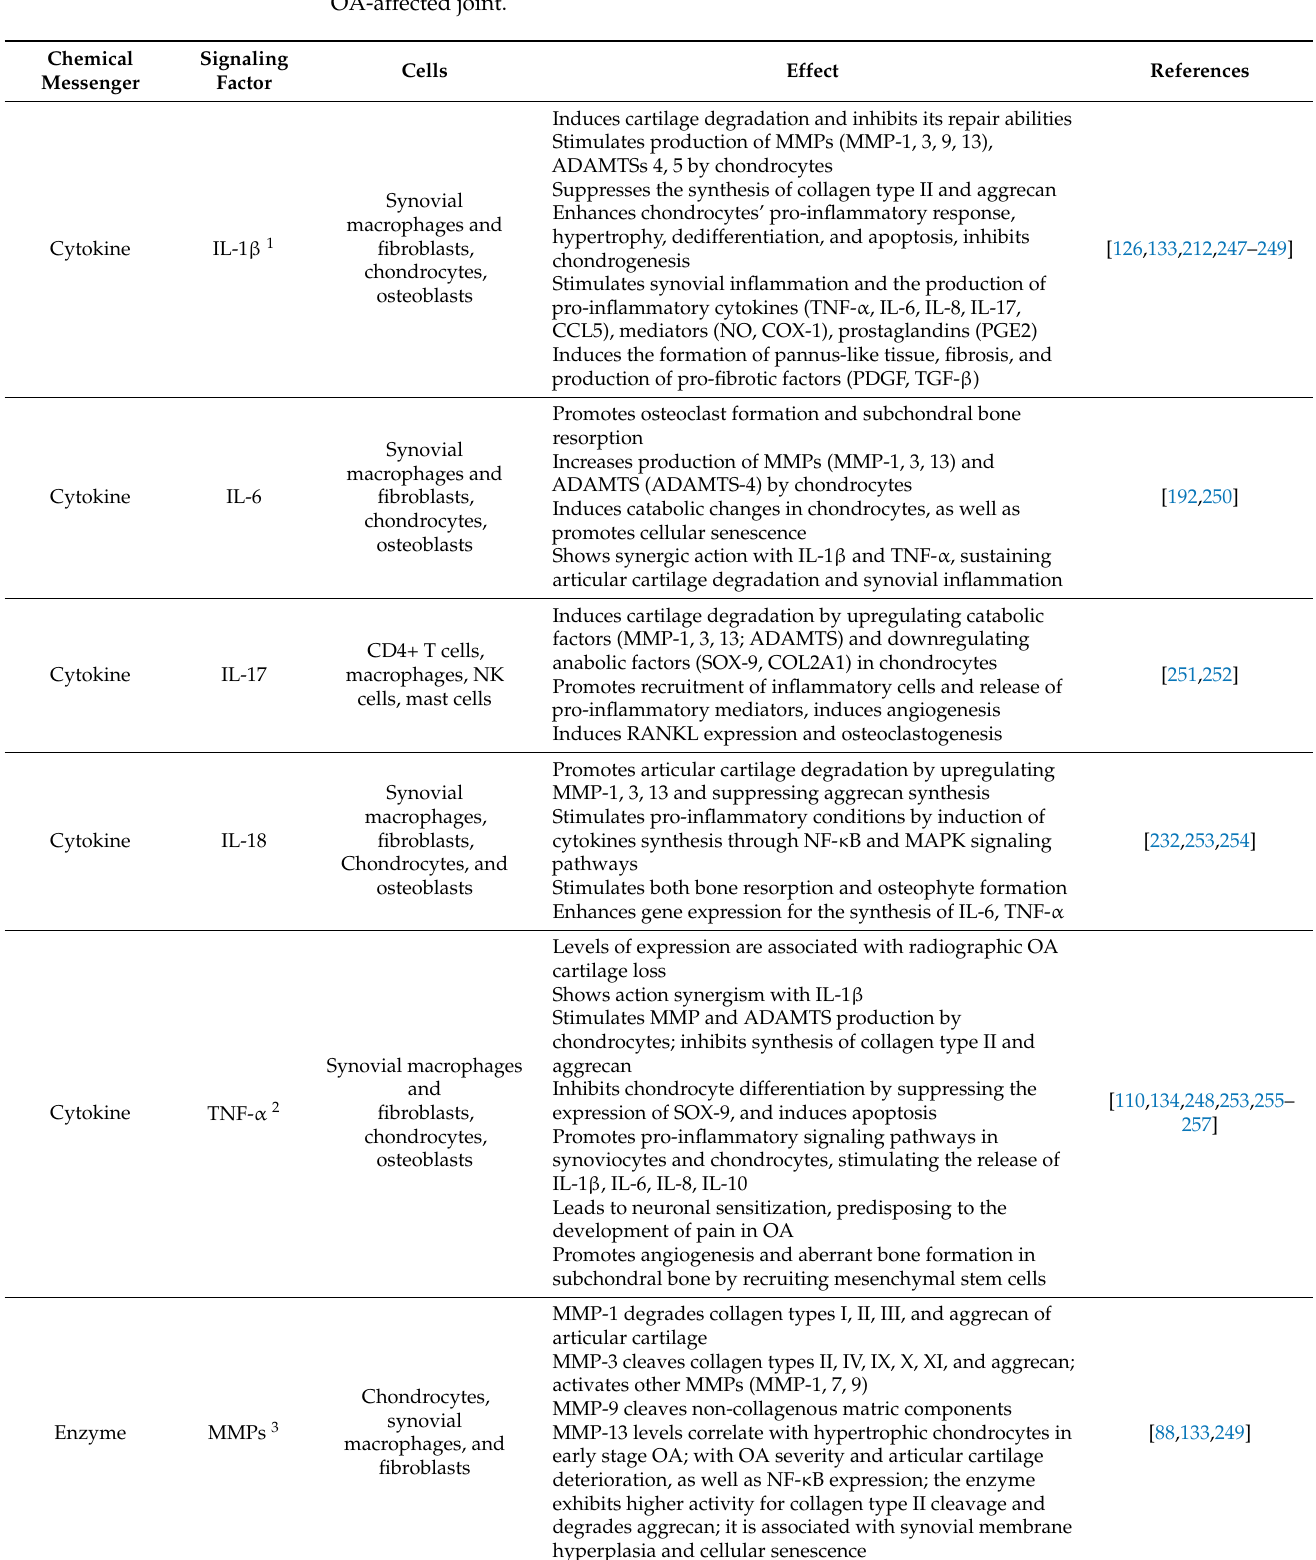
Table 2. The overview of signaling molecules produced by cells in the major joint compartments of OA-affected